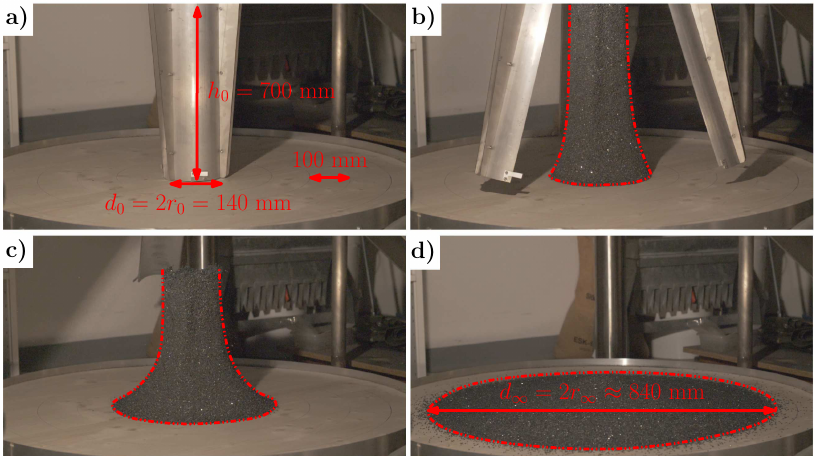
Figure 2. Close-up pictures of the newly designed apparatus used in this study. A cylinder of dimensions 140 × 700 mm is filled with granular material and ( a ) quickly opens radially outward from the column’s centre, ( b ) allowing the granular mass to ( c ) flow freely. The final run-out distance is then measured when ( d ) the collapse has completely relaxed. The initial aspect ratio is typically λ 0 ≤